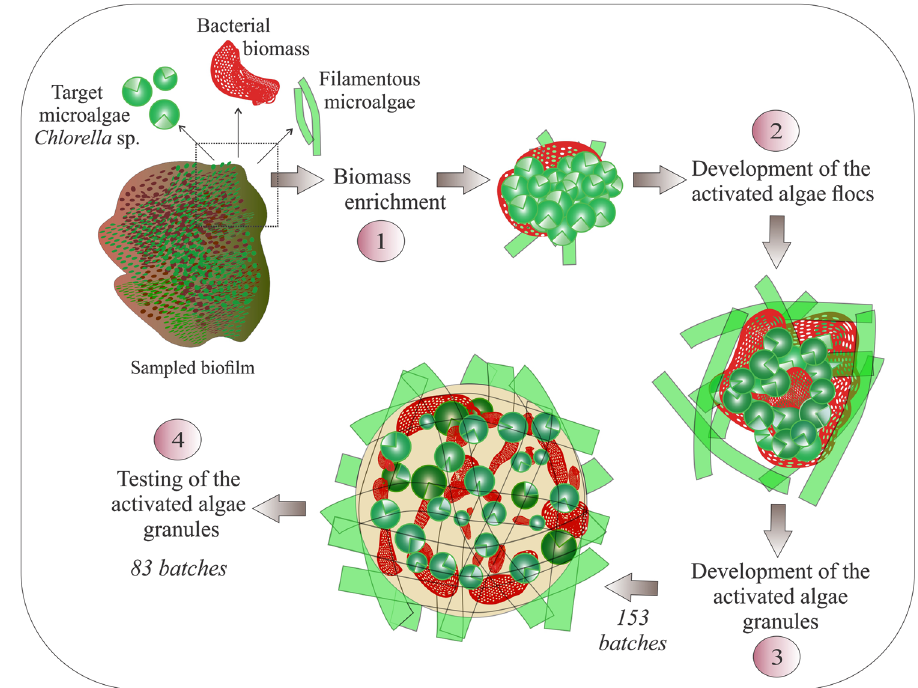
Figure 8. Schematic illustration of the experimental steps. Step 1 – cultivation of the microalgae – bacteria inoculum; step 2 – development of the conventional microalgae-bacteria system; step 3 – implementation of the activated algae granulation procedure; step 4 – validation of the obtained alternative activated algae system in downstream process (microalgae